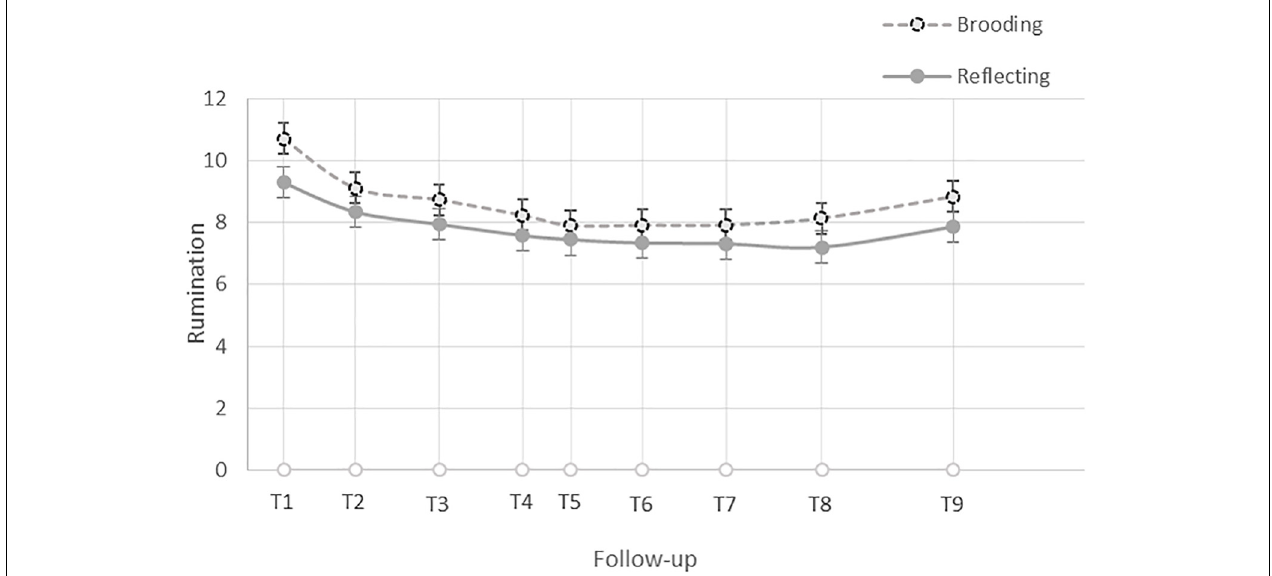
FIGURE 1 | Trajectory of change in the level of brooding and reflection in the 48 h after participants’